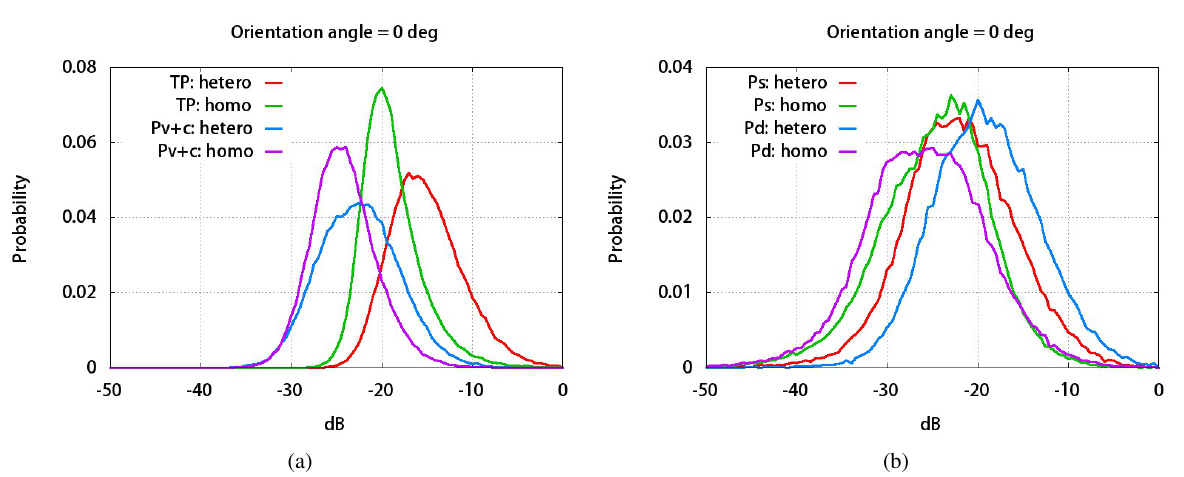
Figure 9. Histograms of scattering of areas with POA around 0 ◦ ( (cid:0) 2 ◦ (cid:20) POA (cid:20) 2 ◦ ) from PALSAR images of the study area. (a) TP and P v + c , and (b) P s and P d . Here, ”hetero” and ”homo” denote areas having heterogeneous and homogeneous POA distributions, respectively (Susaki et al., 2014).